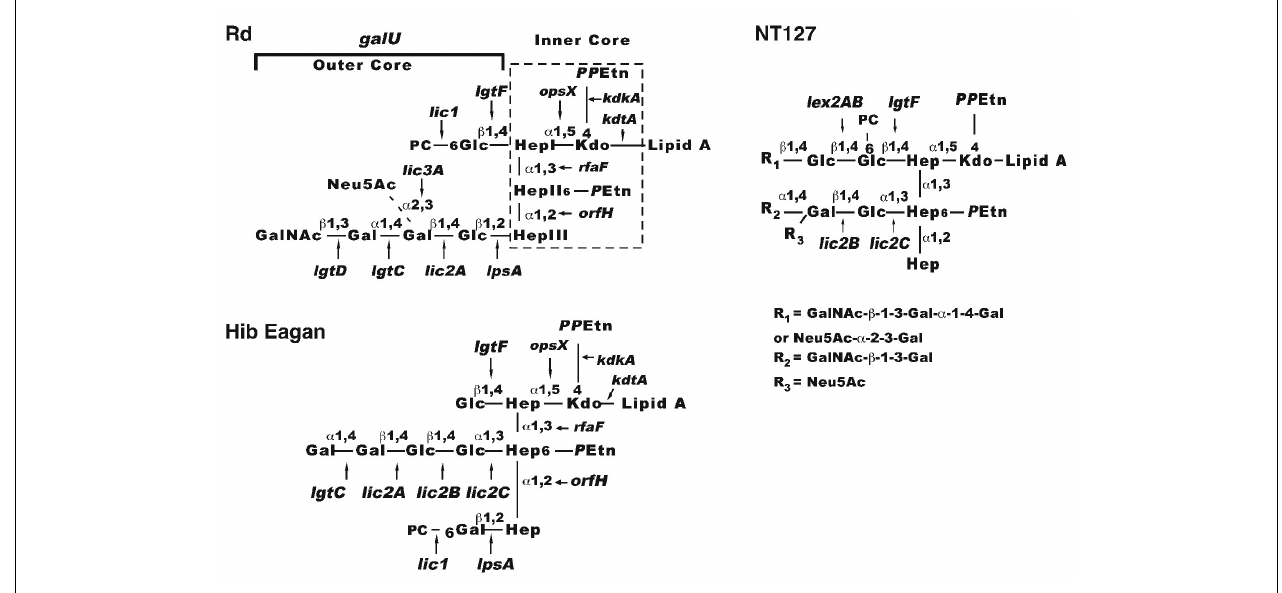
HepIII (the terminal inner core structure). Extending from these heptose residues are the outer core structures (in brackets) dependent on galU for LOS hexose precursor production. Arrows indicate linkages added to the structure by the designated genes. Abbreviations: Glc, glucose; Gal, galactose; Hep, heptose; Kdo, 2-keto-3-deoxyoctulosonic acid; PP Etn, pyrophosphoethanolamine; P Etn, phosphoethanolamine; GalNac, N -acetylgalactosamine; Neu5Ac, sialic acid; PC,